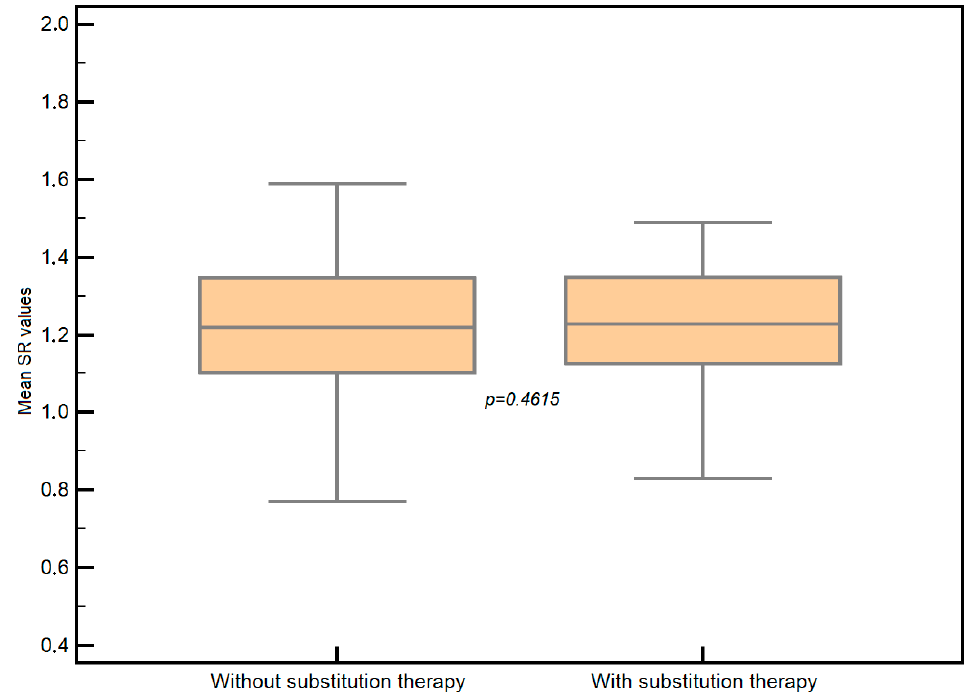
Figure 5. Box-and-whisker distribution plots comparing SR mean values, in euthyroid patients compared to treated hypothyroid patients.